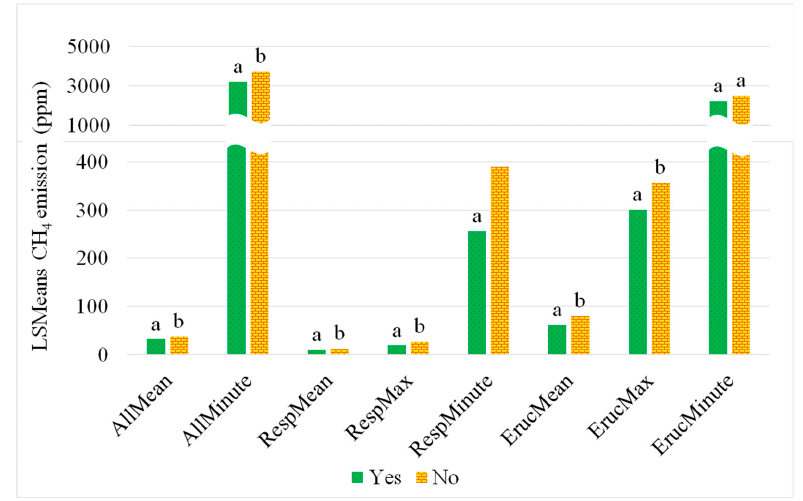
Figure 5. Least square means (LSMeans) for the methane traits in classes with (Yes) and without (No) access to pasture. Different letters on bars indicate significant differences ( p- value < 0.05).